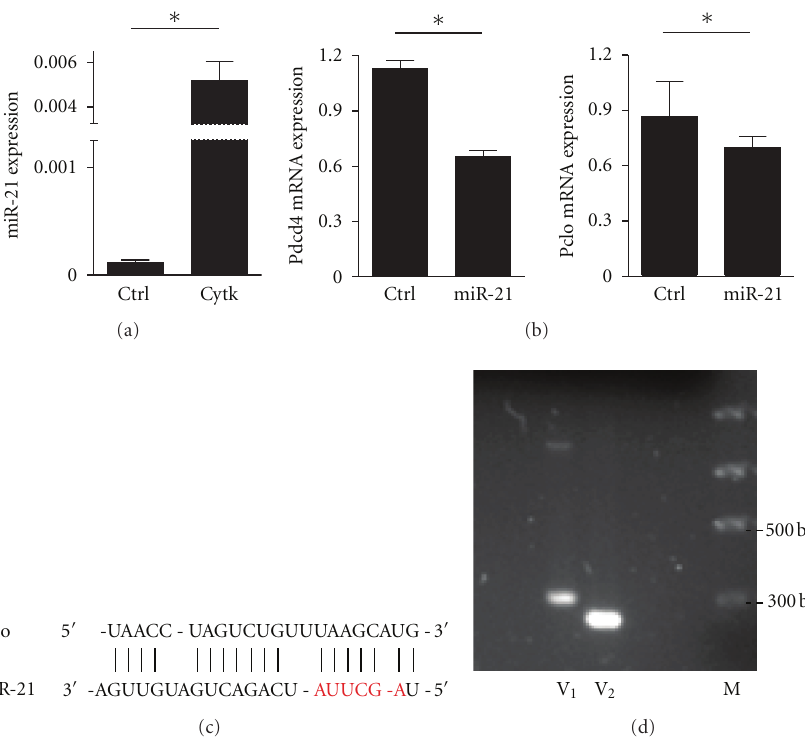
Figure 1: Overexpression of miR-21 regulates endogenous Pdcd4 and Pclo mRNAs. (a) MIN6 cells were treated 24 hours with cytokine cocktail IL-1 β (50U/mL), TNF- α (2000 U/mL), and IFN γ (100U/mL). The expression of miR-21 was assessed by qRT-PCR. (b) Overexpression of miR-21 mimic (300nM) for 48 hs inhibits the expression of endogenous Pdcd4 and Pclo mRNA. Experiments shown in (a) and (b) are expressed as mean ± SD ( n = 5), ∗ P < 0 . 05 ( t -test, 2 tails). (c) miR-21 recognition site in the 3 (cid:4) UTR of Pclo splicing version 2. MiR-21 “seed” is shown in red font. (d) Semiquantitative RT-PCR shows expression of both Pclo versions (V1, V2) in MIN6 insulinoma